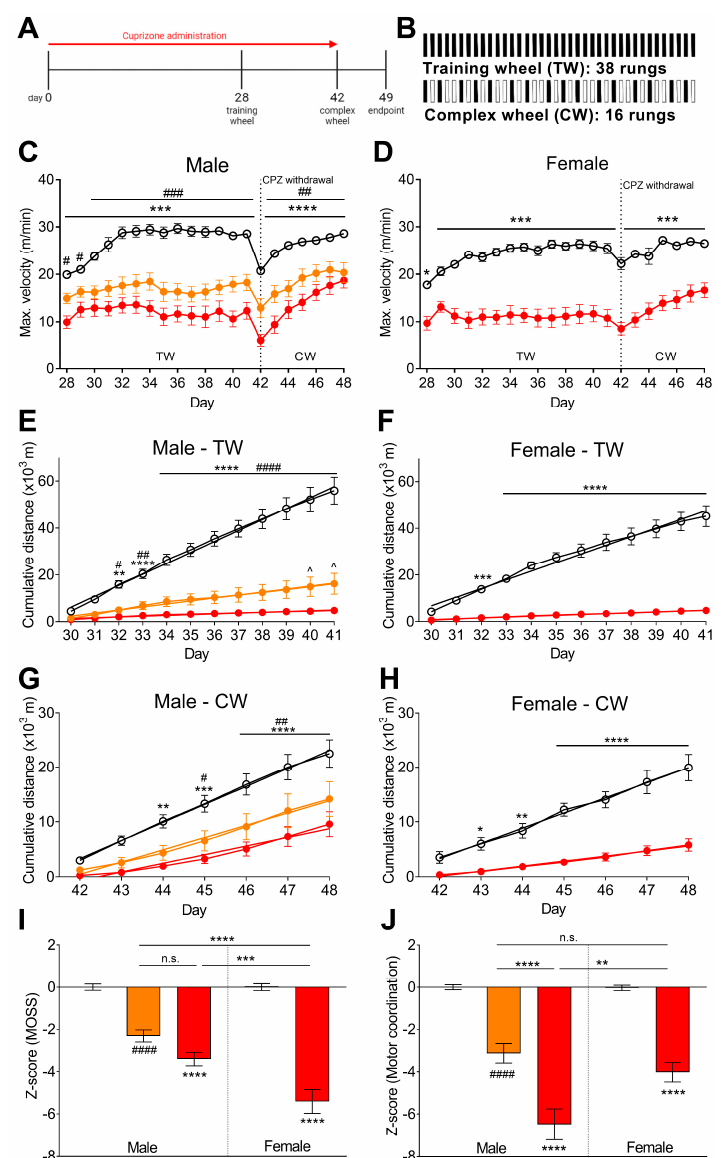
Figure 4. Cuprizone administration decreased complex motor coordination in C57BL/6J mice. ( A ) Timeline of motor skill sequence (MOSS) testing in the cuprizone-induced demyelination model. The training wheel (TW) is used on days 28–42 and the complex wheel (CW) on days 42–49. ( B ) Schematic diagram of MOSS wheel rung pattern, 38 rungs for the training wheel and 16 rungs for the complex wheel. The maximum velocity per day for the length of the experiment in ( C ) males and ( D ) females showed a deficit with cuprizone administration. Cumulative distance travelled was recorded on the ( E , F ) training wheel on days 28–41 and the ( G , H ) complex wheel on days 42–49. Mice on normal food exercised significantly more than cuprizone-intoxicated mice on the training and complex wheel. ( I ) Z-score analysis for the MOSS testing showed the 0.3% cuprizone affected females more severely than males. However, ( J ) z-score analysis of all measures from MOSS testing, horizontal bar and passive wire hang, overall showed that the 0.3% dose in males had the greatest deficit in motor coordination. ( C – H ) Two-way repeated-measures ANOVA with Bonferroni post-tests. ( I , J ) One-way ANOVA with Bonferroni post-tests. # p < 0.05, ## p < 0.01, ### p < 0.001, #### p < 0.0001 for 0.2% cuprizone vs. normal food. ** p < 0.01, *** p < 0.001, **** p < 0.0001 for 0.3% cuprizone vs. normal food, or as indicated. ˆ p < 0.05 for 0.2% cuprizone vs. 0.3% cuprizone. Data presented as mean ± SEM. n =